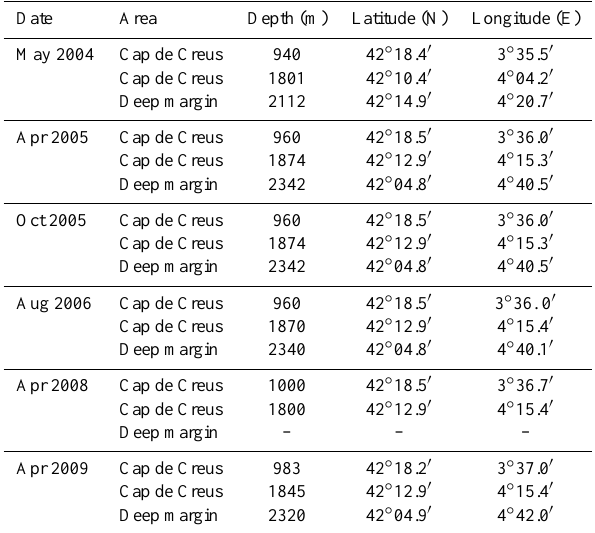
Table 1. Location and depth of sampling stations in the Cap de Creus Canyon and deep Pusceddu et al. Major consequences of an intense Dense Shelf Water Cascading event on deep-sea benthic trophic conditions and meiofaunal biodiversity